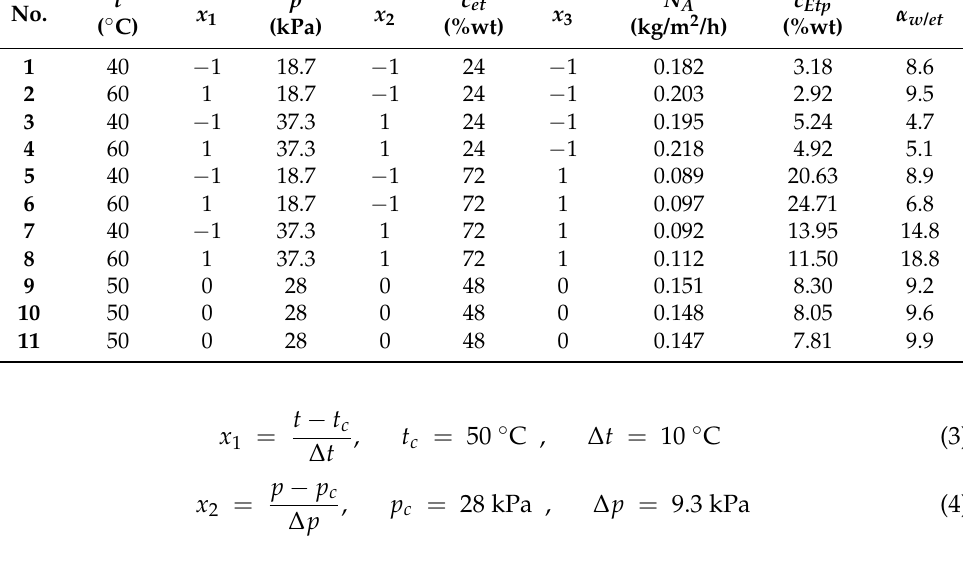
Table 2. Process factors and responses for PVA-BC 12/12 membrane